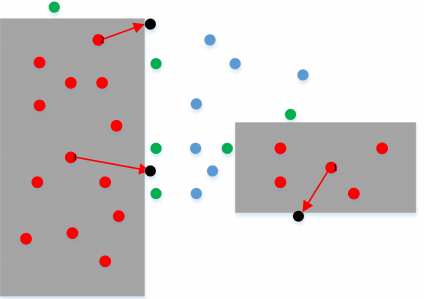
Figure 12. Optimizing obstacle points as the free points in free space.